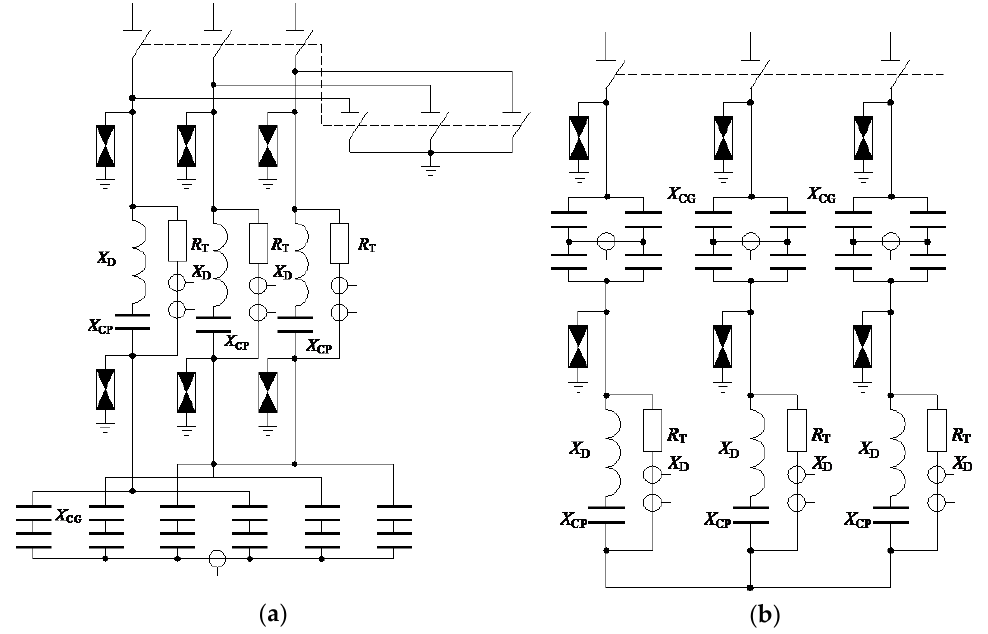
Figure 8. Active power of a higher harmonic discharged on the damping resistor R T and in the transmission system as a function of the resistance of the damping resistor R T . ( a ) Double-star connection. ( b ) H-bridge.